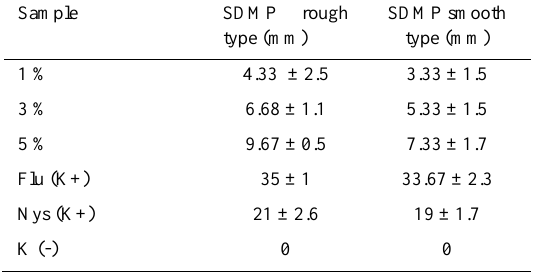
Table 4. The diameter of microbial inhibitory of